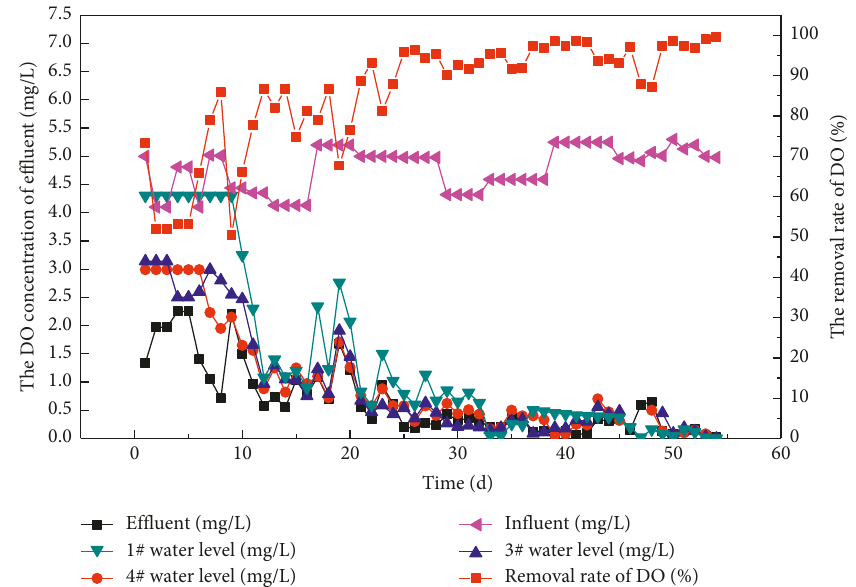
Figure 7: Curve of dissolved oxygen concentration and dissolved oxygen removal efficiency with time in different water